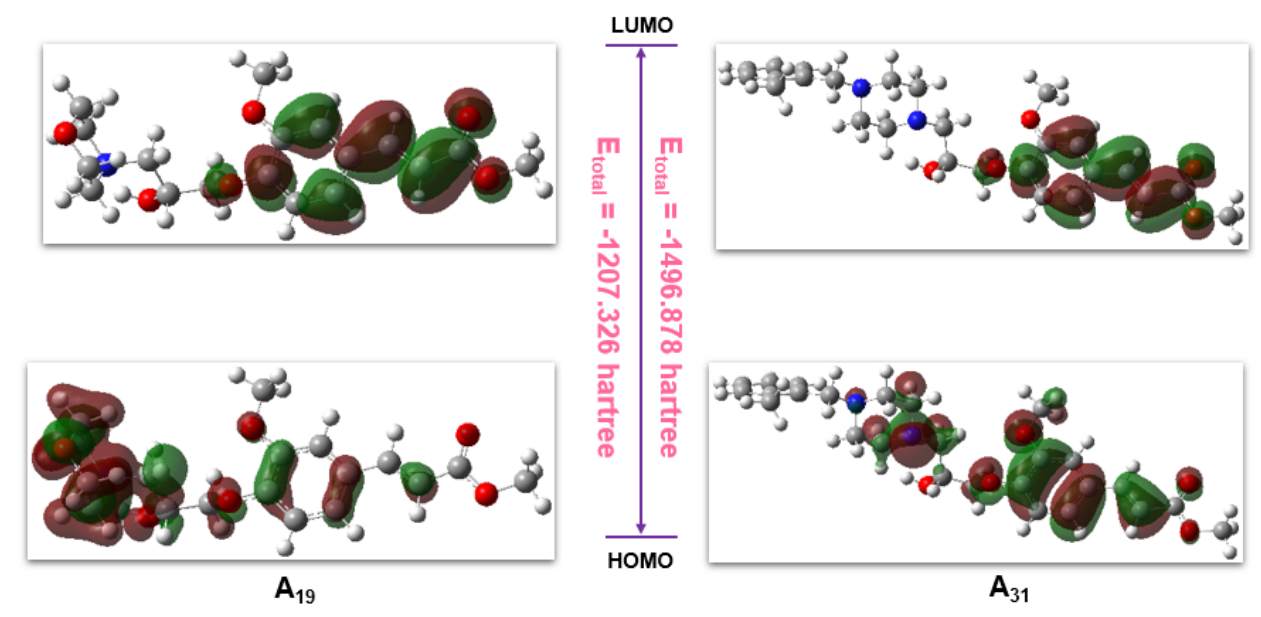
Figure 12. Frontier molecular orbitals of compounds A 19 and A 31 .